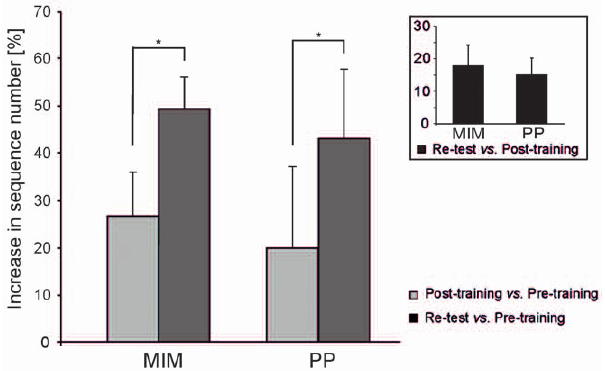
Figure 4. Early boost following MIM and PP training. The increase in the total number of sequences between the post-training and re-test sessions is expressed in percent with respect to data gathered in the pre-training session. This shows that MIM and PP training led to the same increase in performance in the post-training and re-tests sessions and confirms the occurrence of an early boost in both groups. The inset shows the amplitude of the early boost, estimated as the difference between the total number of sequences in the re-test and post-training sessions - in both groups and expressed in percent; no difference in early boost amplitude was found between the two groups. Error bars indicate one SD.